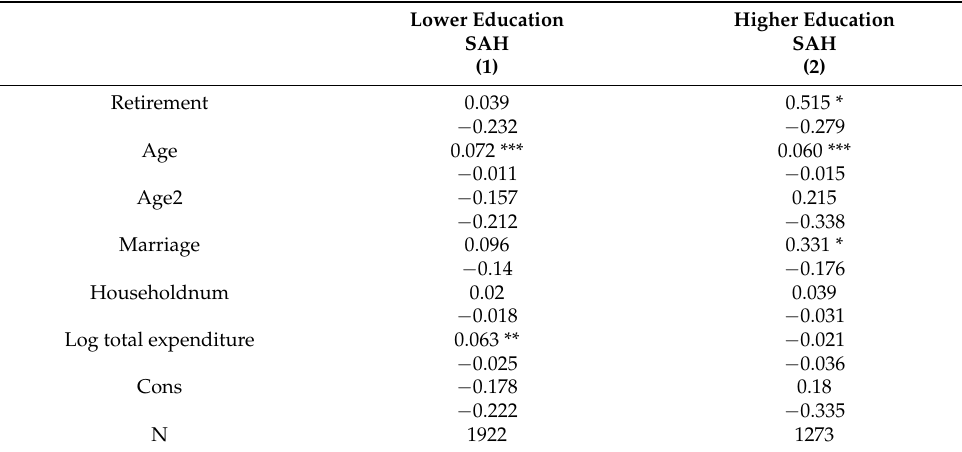
Table A6. Effect of retirement on SAH by